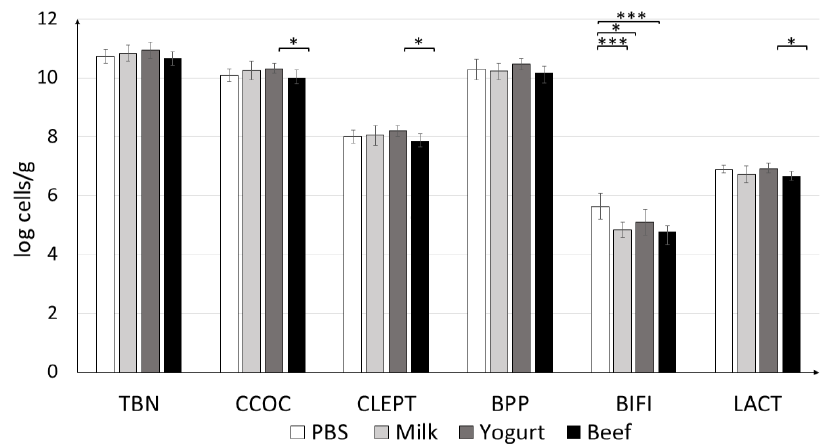
Figure 8. Effects of antigen treatments on mouse fecal microbiota profile. qPCR results are presented as log 10 of bacterial cells per gram of the wet weight of the fecal content of experimental animals. Data are the mean ± SD. * p < 0.05, *** p < 0.001. TBN = total bacteria; CCOC = Clostridium coccoides ; CLEPT = Clostridium leptum ; BPP = Bacteroides-Prevotella-Porphyromonas ; BIFI = Bifidobacterium ; LACT = Lactobacillus .